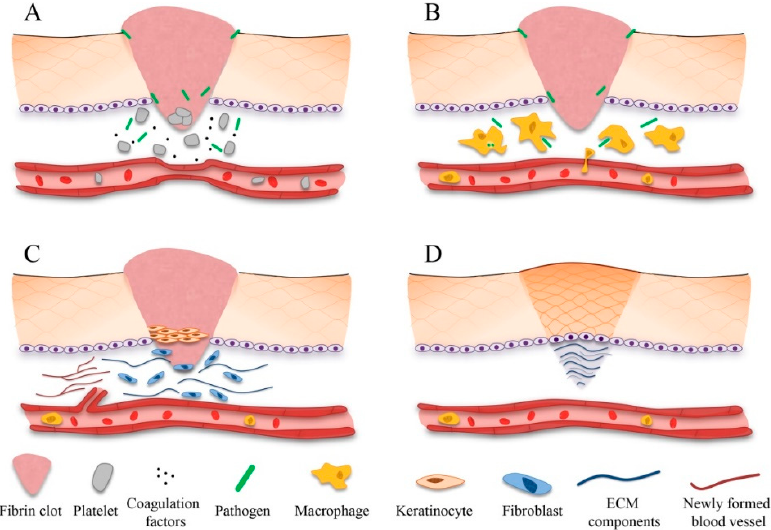
Figure 4. Wound healing process: ( A ) hemostasis, ( B ) inflammation, ( C ) proliferative phase and ( D ) remodeling phase. Reproduced with permission from [106] , 2017, copyright 2017 Elsevier B.V.